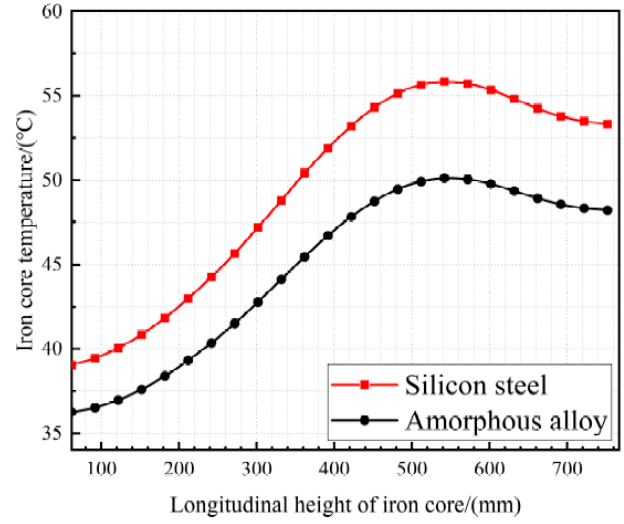
Figure 10. Longitudinal temperature curve of the core.